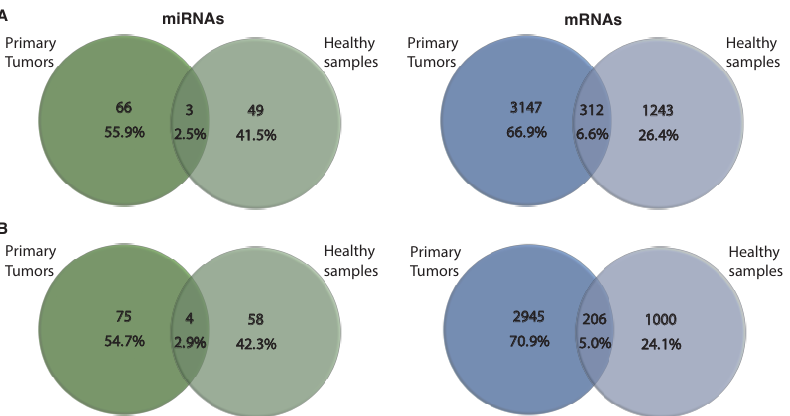
Figure 6. Venn diagram of overlap detected miRNA and mRNA signatures by MSRFR using primary tumors and healthy samples of ( A ) lung and ( B )